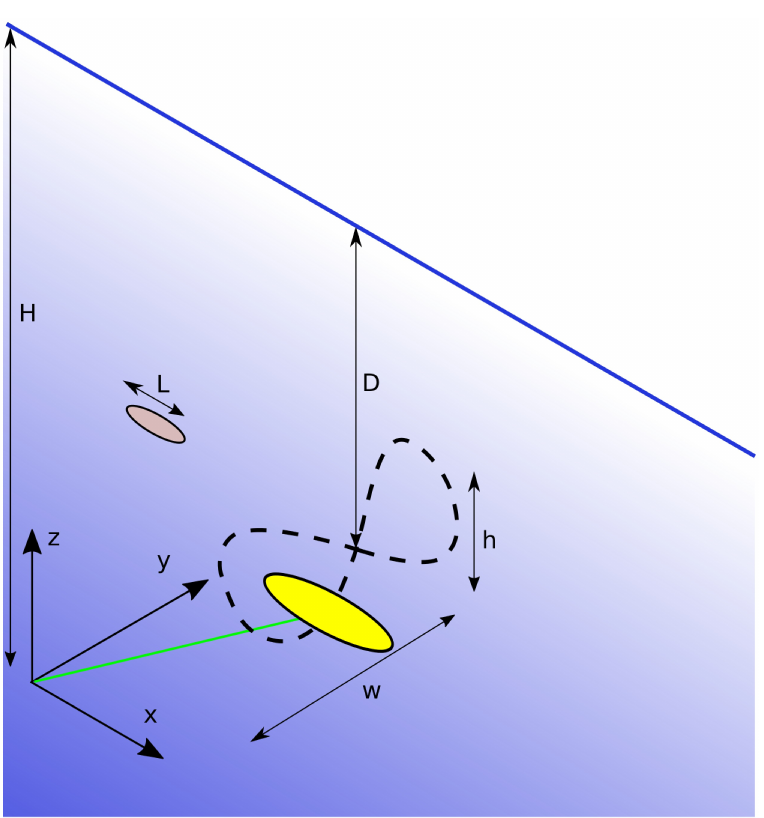
Fig 1. Schematic illustration of the tidal kite (yellow), tether (green) and flightpath (dashed line) with main variables as defined in Table 1 and coordinate systemas used in the simulations. The grey elliptic symbol represents the animalunder risk of collision.The foundation is locatedat the